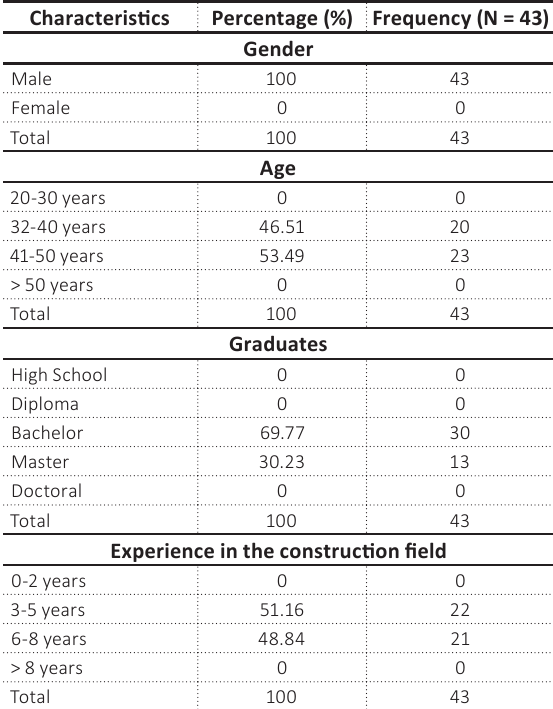
Table 2. Characteristics of